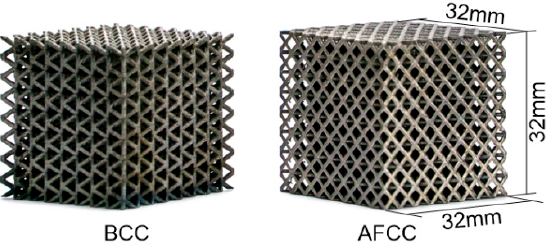
Figure 10. Selective laser melting (SLM) forming sample of AFCC and BCC structures with dimensions of 32 mm × 32 mm × 32